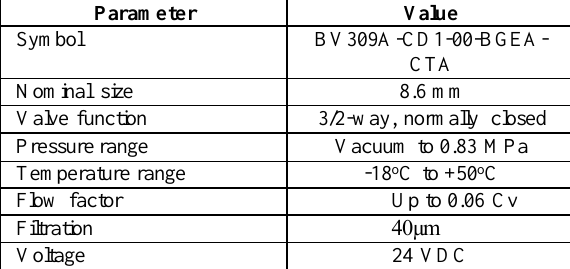
Table 1. Parameters of the valve BV309A-CD1-00-BGEA- CTA.